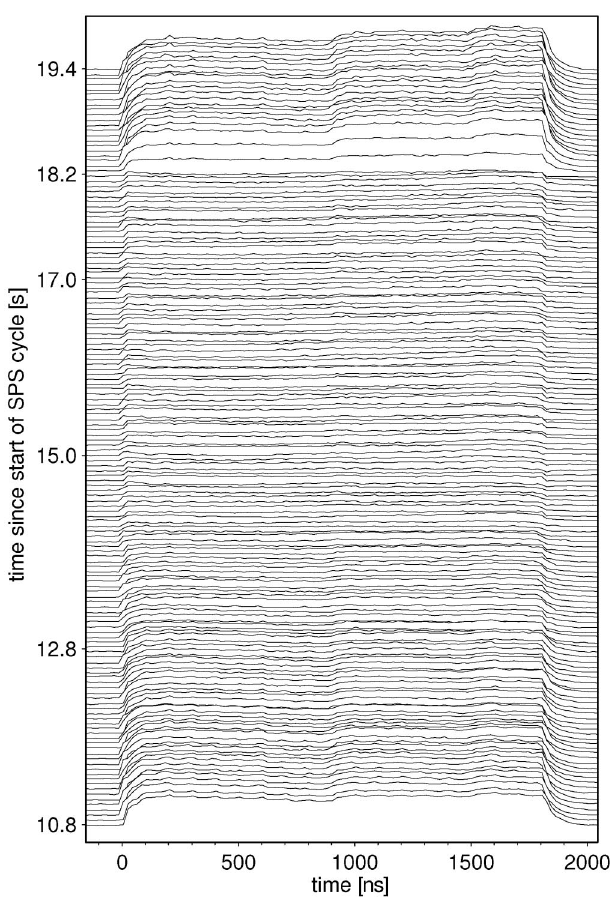
FIG. 9. Mountain range of phase pickup. The 800 MHz system is off and the rf AM is switched on at 12.8 s (64 GeV).